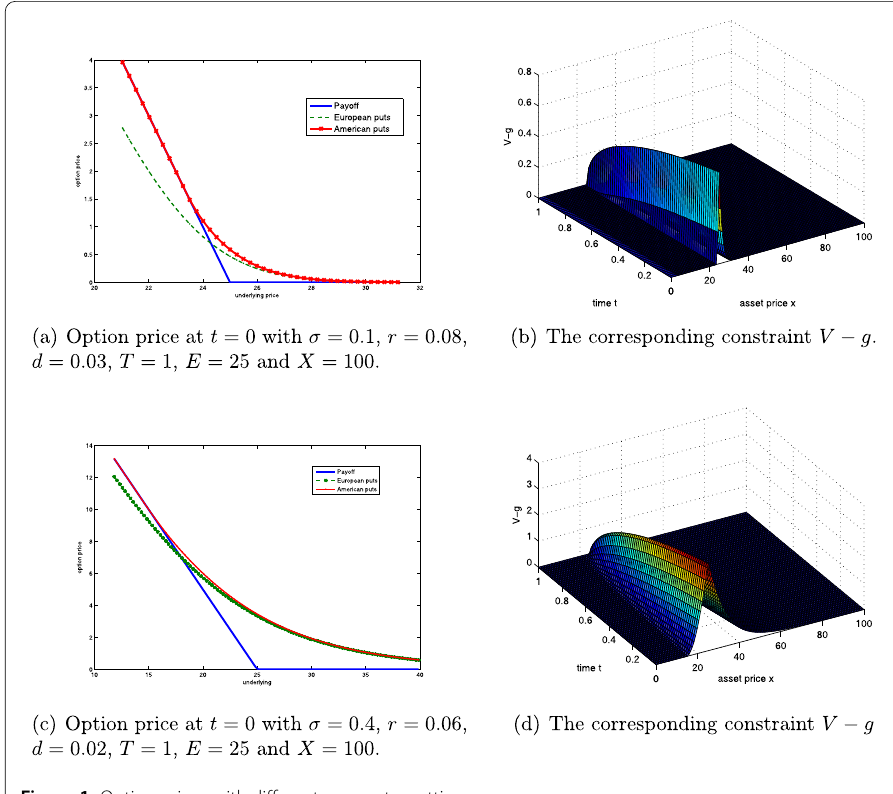
Figure 1 Option prices with different parameter